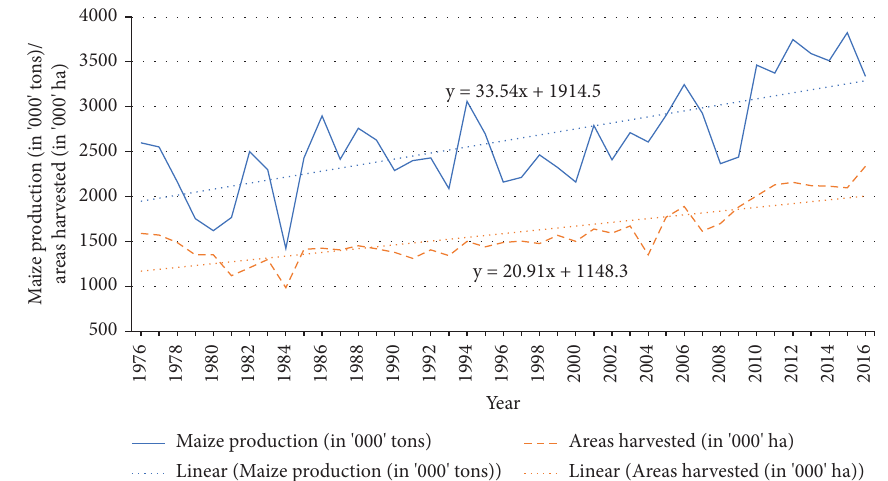
Figure 1: Te trend of maize production and area harvested [22].